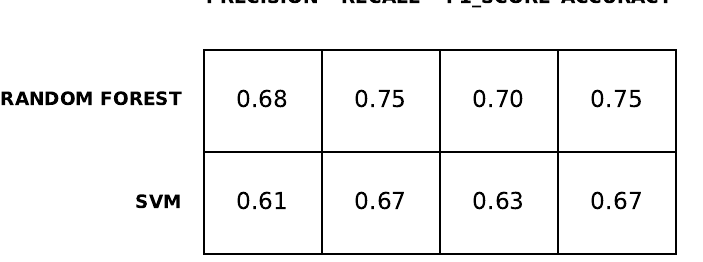
Figure 6. Results of the prediction of anxiety